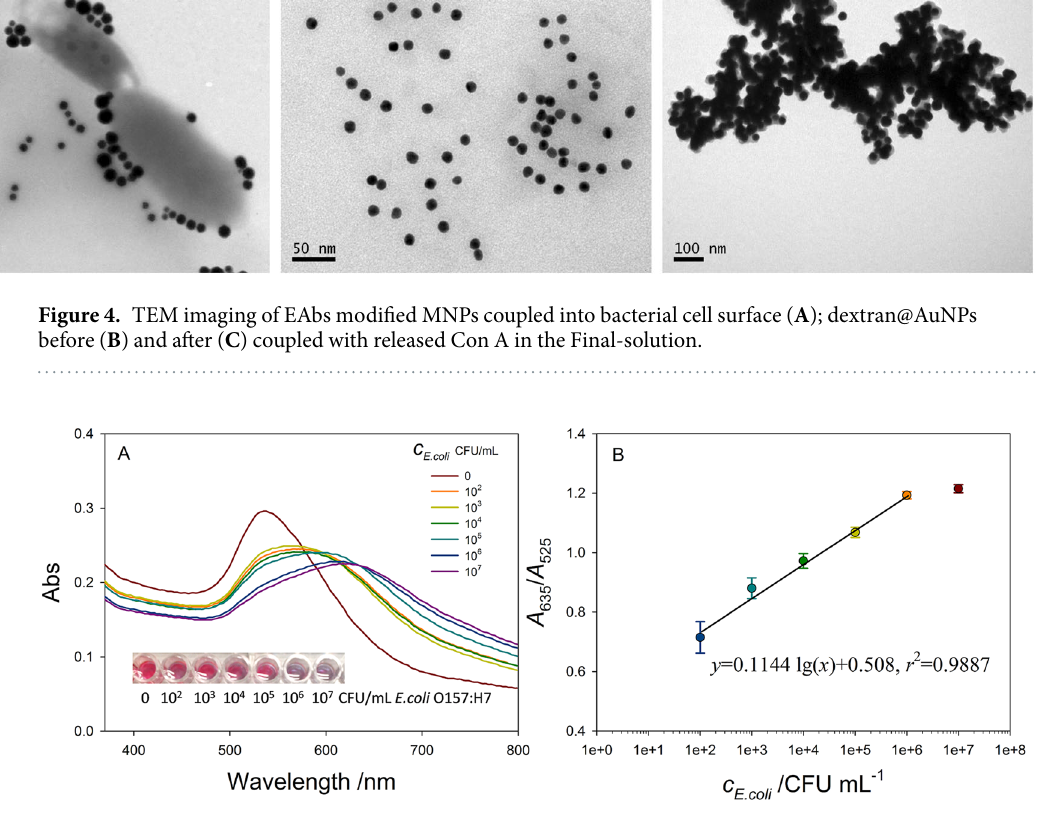
Figure 5. ( A ) UV-vis spectra of dextran@AuNPs with released Con A in different concentration of E . coli O157:H7. Inset is the photos of dextran@AuNPs mixed with released Con A at the concentration of 0, 10 2 , 10 3 , 10 4 , 10 5 , 10 6 , 10 7 CFU/mL bacteria. ( B ) Linear relationship between the absorption change ratio A 635 / A 525 and the concentration of E . coli ( N =